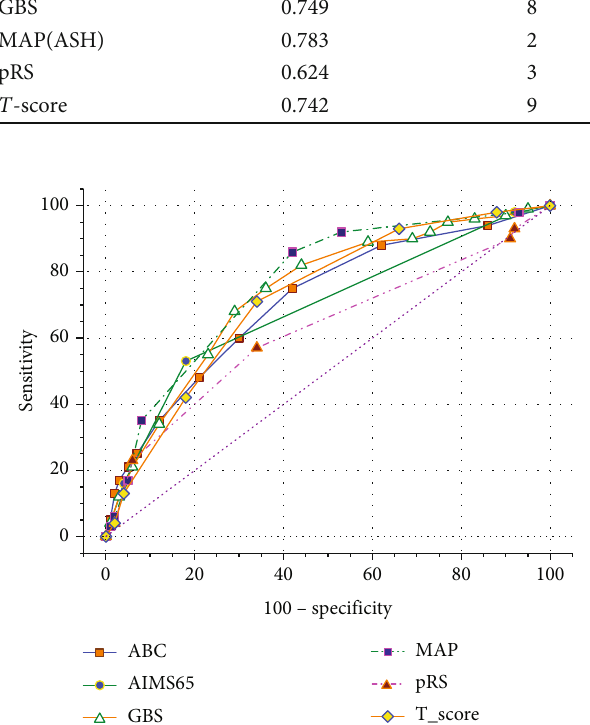
Figure 2: ROC curves for six scoring systems in evaluation of